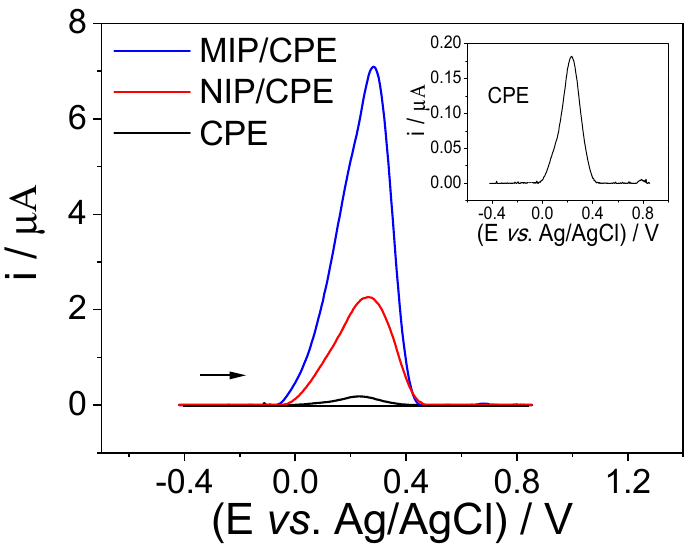
Figure 7. Square-wave voltammograms obtained for the modified electrodes. Analysis conditions: 0.1 mol L − 1 acetate buffer solution (pH 4.0). SWV conditions: f = 15 Hz, a = 75 mV, ∆ Es = 5 mV and [folate] = 2.2 × 10 − 5 mol L − 1